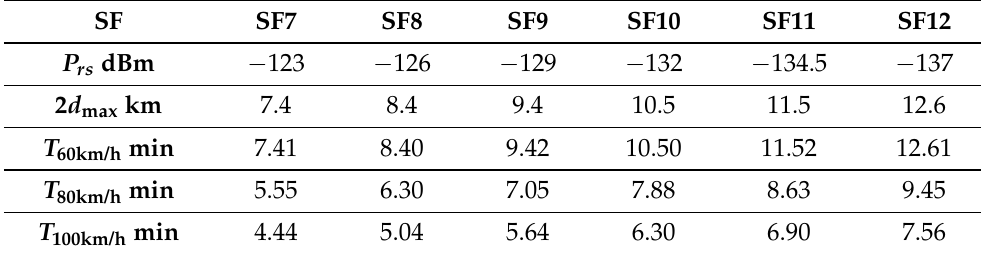
Table 1. Upper bounds of transmission distance and visibility time for each